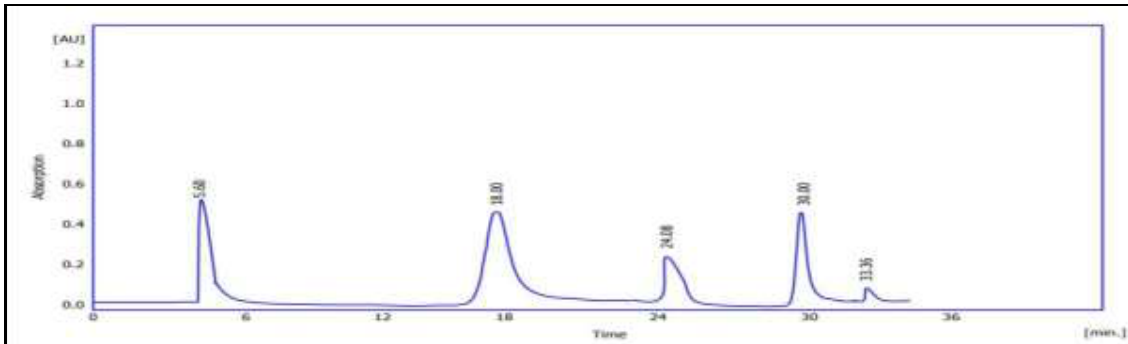
Figure 9. PHPLC chromatogram of petroleum ether fraction of leaves that extracted by cold method.